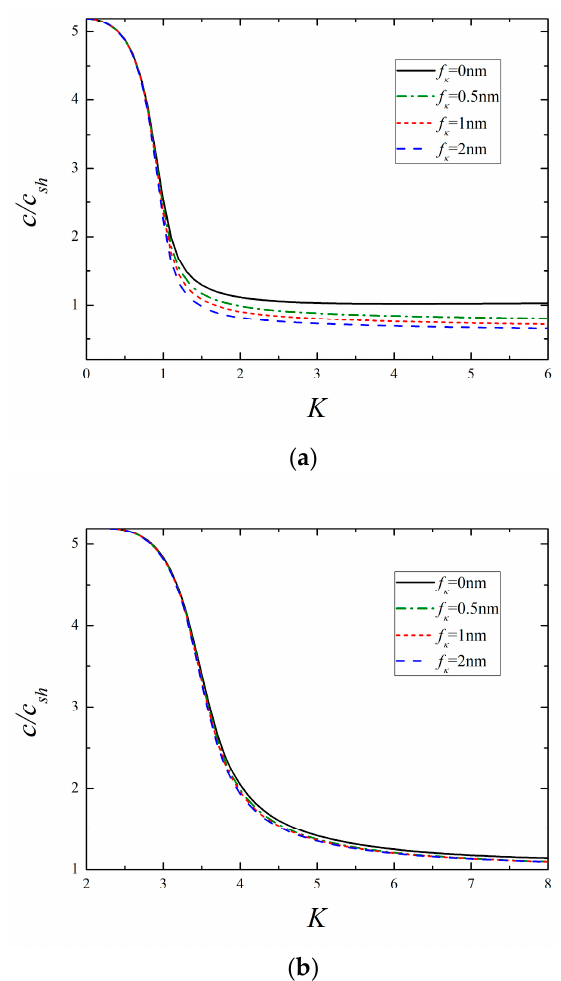
Figure 6. The lowest two modes for different surface dielectricity ( f c = f e = 0.5 nm, f ρ = 1 nm). ( a ) The 1st mode and ( b ) the 2nd mode.